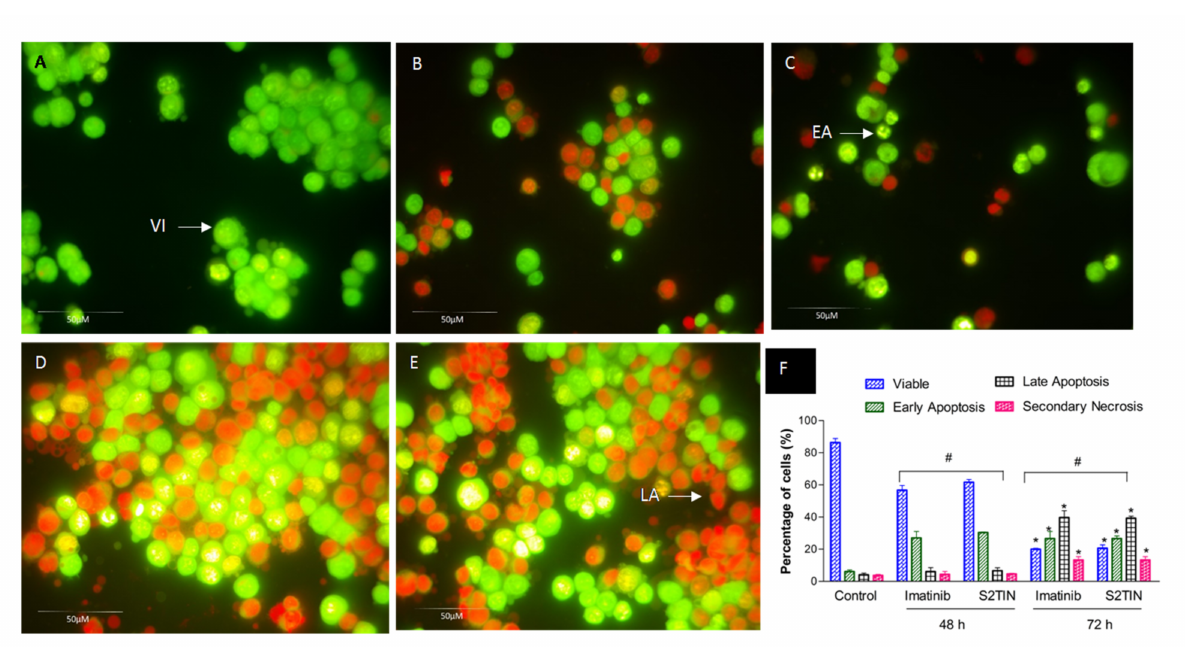
Figure 7. Fluorescent micrographs of acridine orange/propidium iodide double-stained MCF-7 breast cancer cells treated with IC 50 concentrations of IMA and S2TIN for 48 and 72 h. ( A ) The untreated cells show a normal structure without prominent apoptosis or necrosis (bright green). ( B , C ) Early apoptosis features seen after 48 h treatment (bright green) with IMA and S2TIN, respectively. ( D , E ) Late apoptosis was observed at 72 h (orange color) with IMA and S2TIN, respectively. ( F ) Percentages of viable, early apoptotic, late apoptosis, and secondary necrotic cells after treatment. * p < 0.05 compared to the control; # no significant difference between groups. VI, viable cells; EA, early apoptosis; LA, late apoptosis. Each experiment was performed in